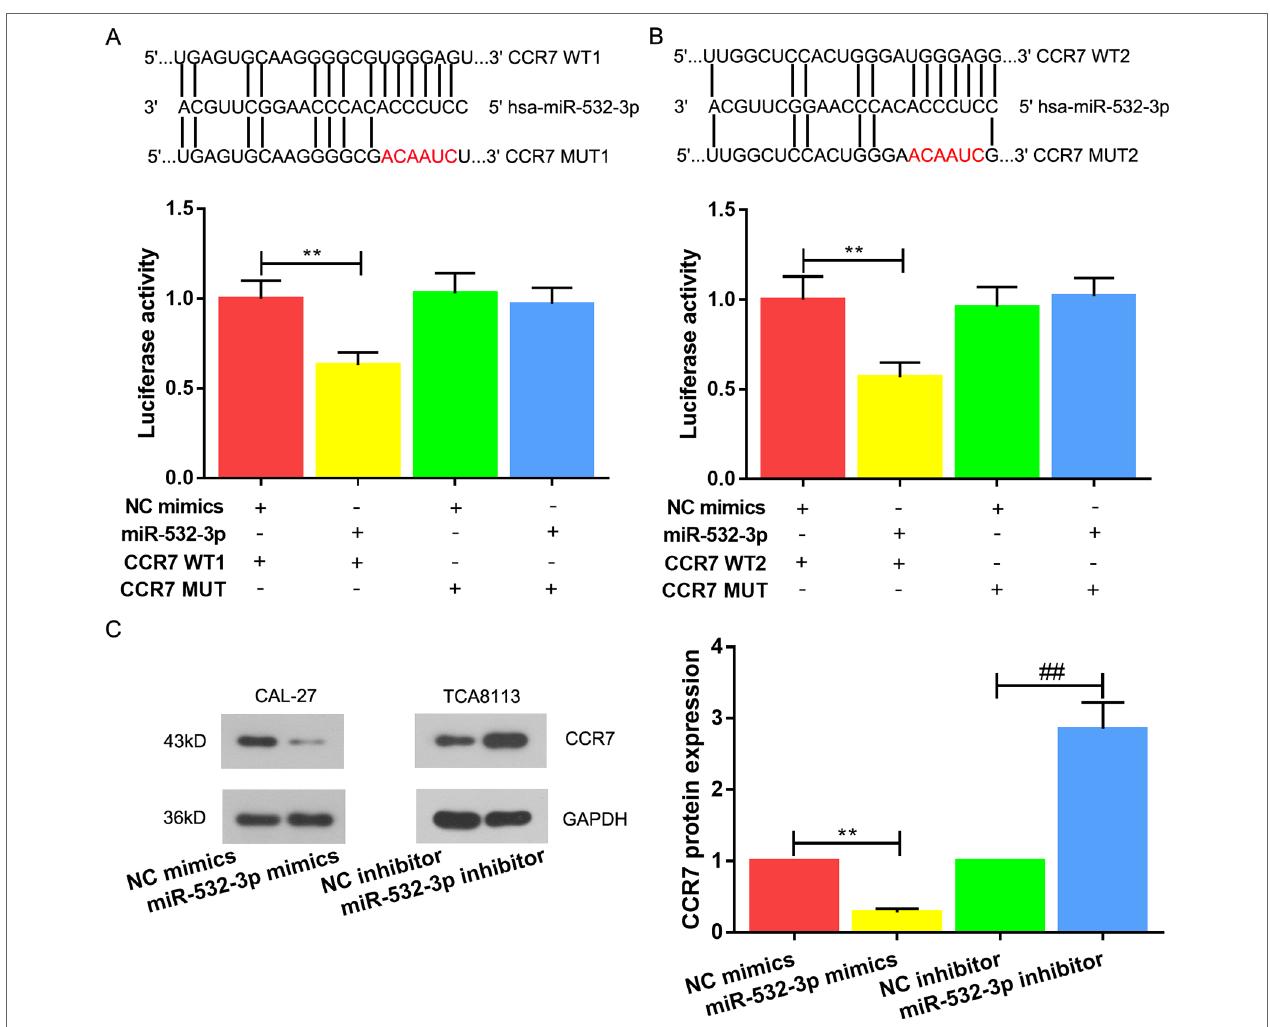
FIGURE 4 | CCR7 is a direct target of miR-532-3p in TSCC. Putative wild-type (WT) and mutant (MUT) miR-532-3p binding sites in the 3’-UTR of CCR7. (A, B) Relative luciferase activities were analyzed in 293T cells co-transfected with WT (1 and 2) or MUT (1 and 2) reporter plasmids and miR-532-3p mimics or NC mimics. (C) CCR7 protein expression was ameliorated post-transfection miR-532-3p mimics in CAL-27 cell, whilst the expression of CCR7 was enhanced post- transfection miR-532-3p inhibitor. ** and ## means p <